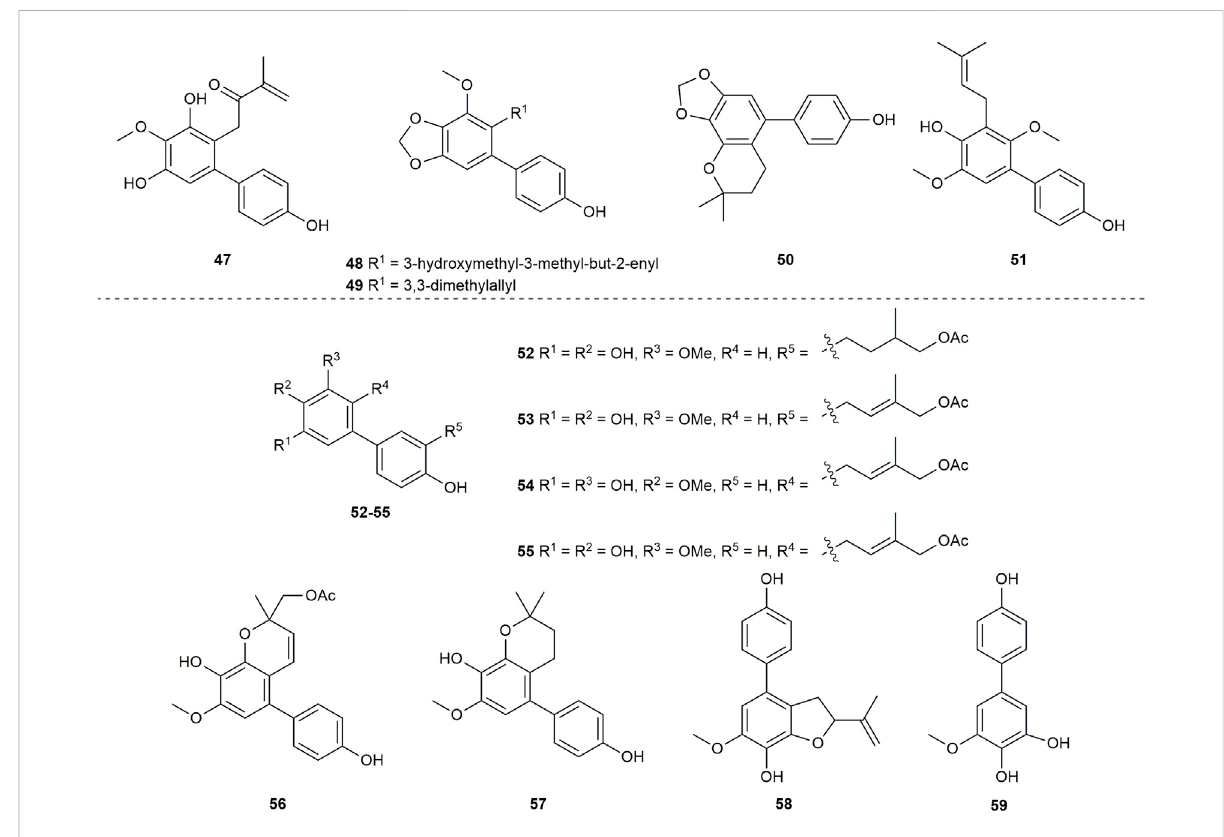
FIGURE 5 Structures of biphenyls 47 – 59